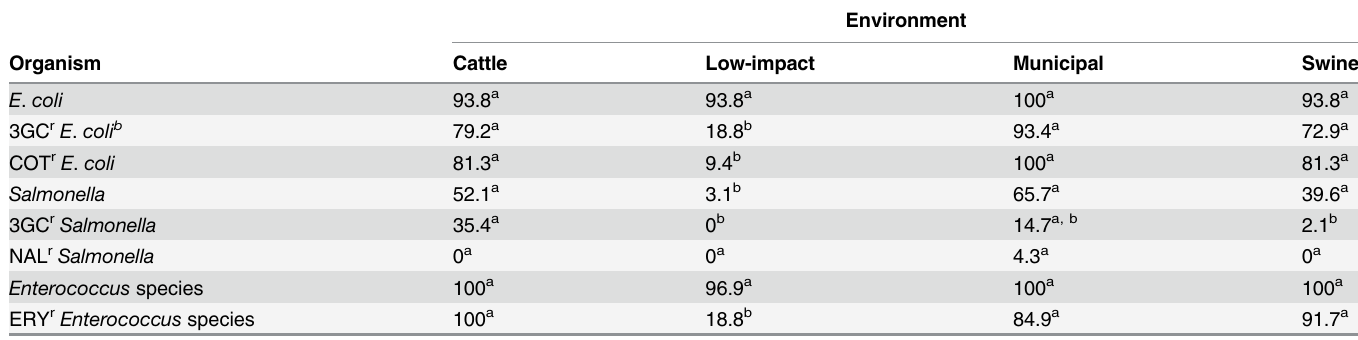
Table 1. Model adjusted prevalence (%) of E . coli , Salmonella and Enterococcus species from cattle (n = 48), low impact environment (n = 32), municipal (n = 46) and swine (n = 48) samples a .